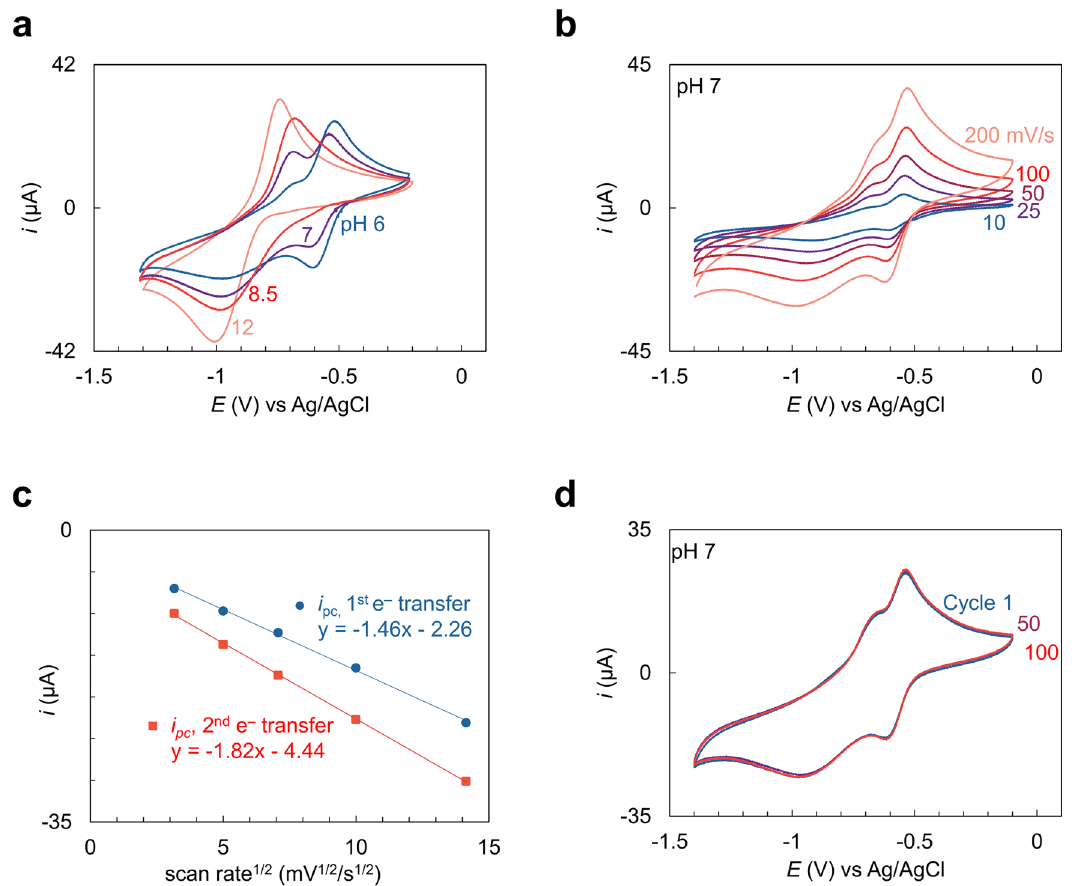
Fig. 2 | Cyclic voltammetry of NR in aqueous solutions. a The cyclic voltam- mogramsof10mMNRatpH6(blue),7(purple),8.5(red),and12(pastelred)in1M NA and 0.1M LiClO 4 solutions under nitrogen with a glassy carbon working elec- trode, at a scan rate of 50mV/s. Potentials were recorded versus Ag/AgCl as a referenceelectrode. b CyclicvoltammogramsofNRwithscanratesof10(blue),25